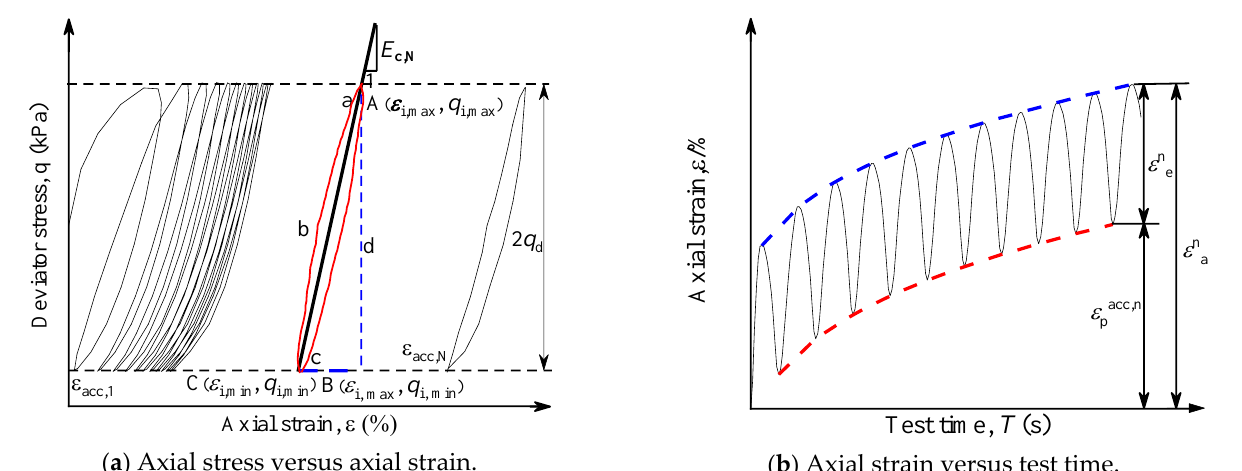
Figure 3. Schematic of axial stress – strain under cyclic loading.